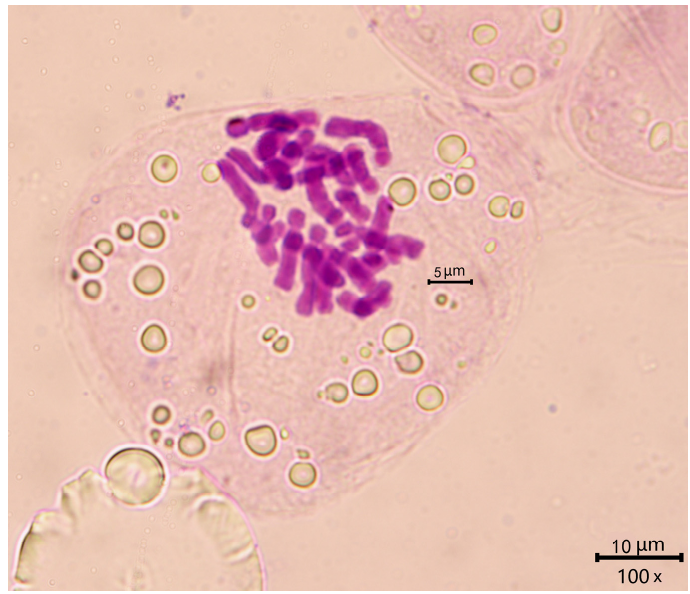
Figure 6. Chromosome number of Amana hejiaqingii (2 n = 2 x =